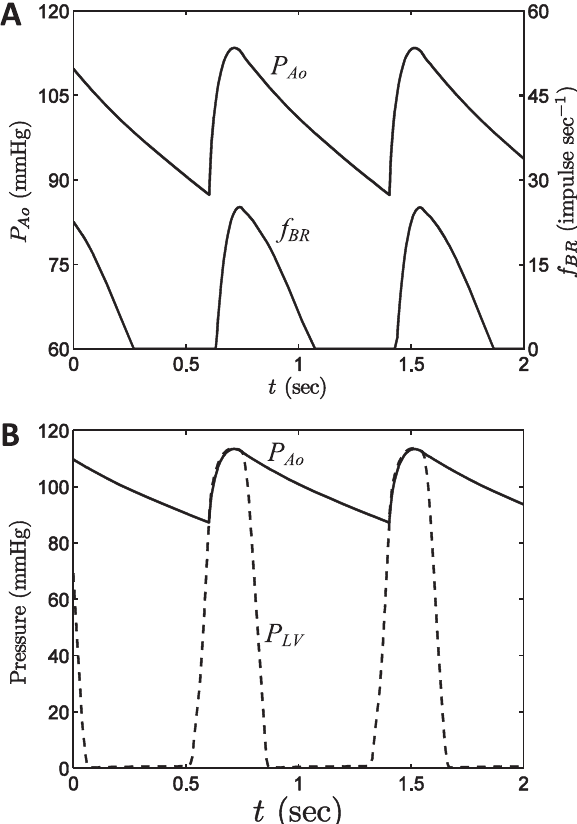
Figure 5. Baseline model operation. A . Model-predicted aortic pressure and baroreflex firing rate, obtained with Q min -1 . This simulation represents a period steady-state of the model, in which Q = Q and average pressure is 100 mmHg. B . Model- in out predicted aortic and left-ventricular pressures are plotted for the baseline period steady